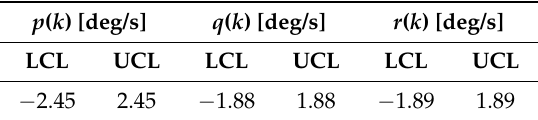
Table 5. Fixed fault detection thresholds for the three IMU